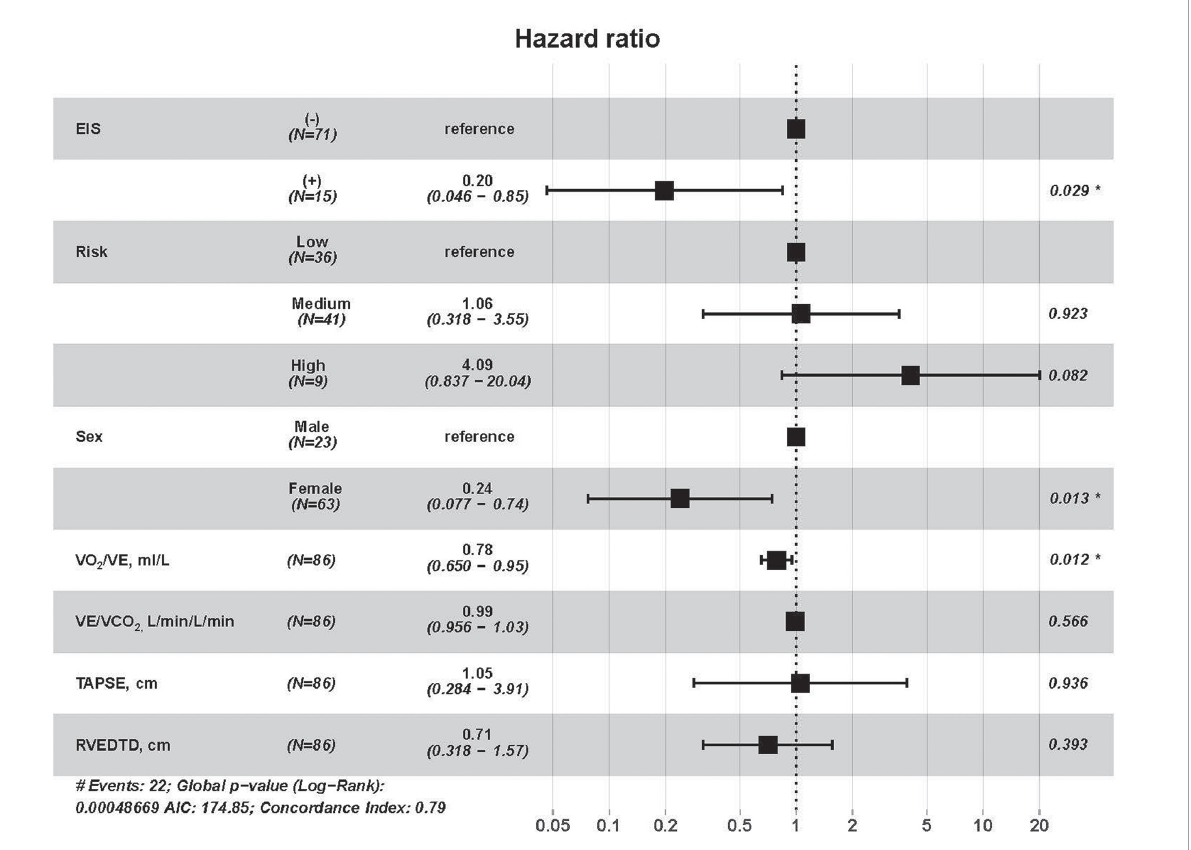
FIGURE5 Cox univariate regression analyses for all-cause mortality among IPAH patients. RVEDTD, right ventricular end-diastolic transverse dimension; TAPSE, tricuspid annular plane systolic excursion; EIS, exercise-induced right-to-left shunt; VCO 2 , carbon dioxide output; VE, minute ventilation; VO 2 , oxygen uptake; IPAH, idiopathic pulmonary arterial